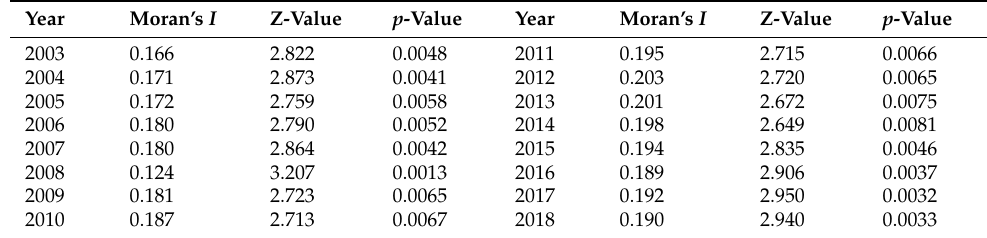
Table 2. Results of ULUE spatial autocorrelation from 2003–2018. Moran’s I, global Moran’s index.